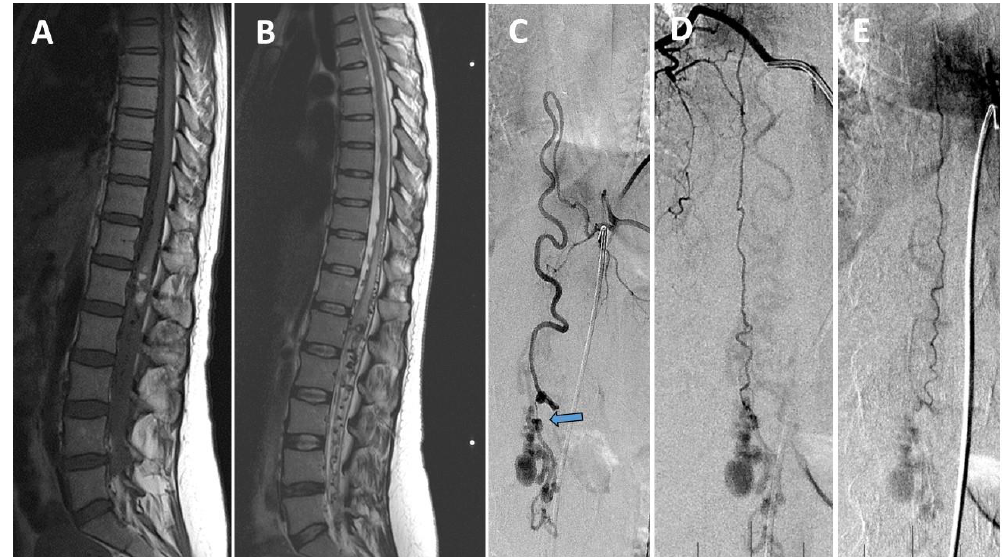
Figure 2. Intramedullary hematoma and perimedullary arteriovenous fistula (PMAVF). ( A ) Sagittal T1—weighted MRI showed an intraconal hemorrhage at the level of L1. ( B ) Sagittal T2—weighted MRI demonstrated myelopathy and dilated veins at the level of T10 to L5. ( C – E ) Initial spinal digital subtraction angiography revealed supplying arteries of the PMAVF; ( C ) Dilated anterior spinal artery with the increased flow is the main PMAVF feeder (blue arrow pointing to the fistula). ( D ) Right posterior spinal artery and ( E ) left posterior spinal artery also supplying the PMAVF.